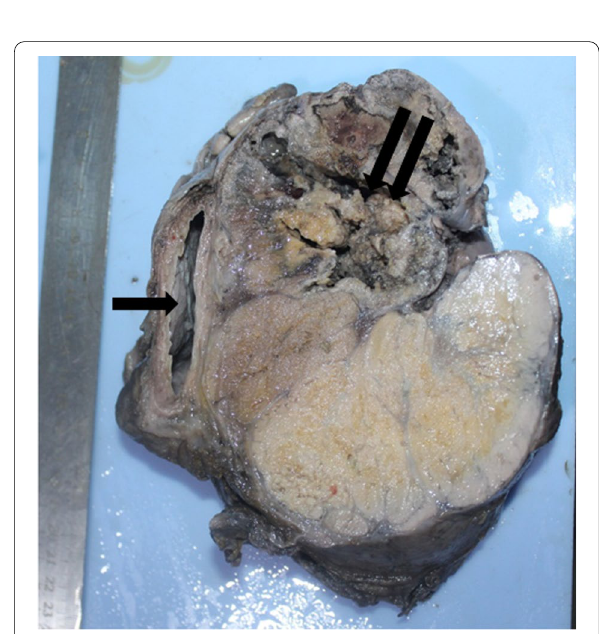
Fig. 2 Cut sections of the bladder tumour showing solid multilobulated surfaces with areas of haemorrhage and necrosis (double arrows). The bladder lumen is seen on the left (single